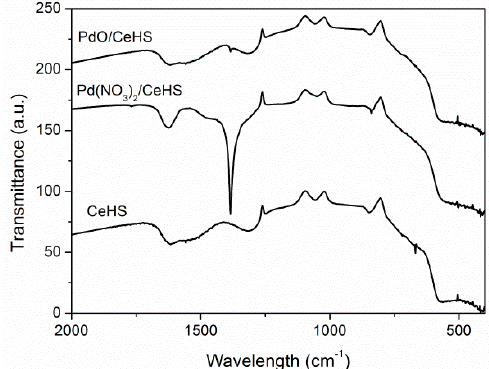
Figure 2. Fourier transform infrared (FT-IR) spectra of PdCeHS before and after thermal treatment compared with bare CeHS support.